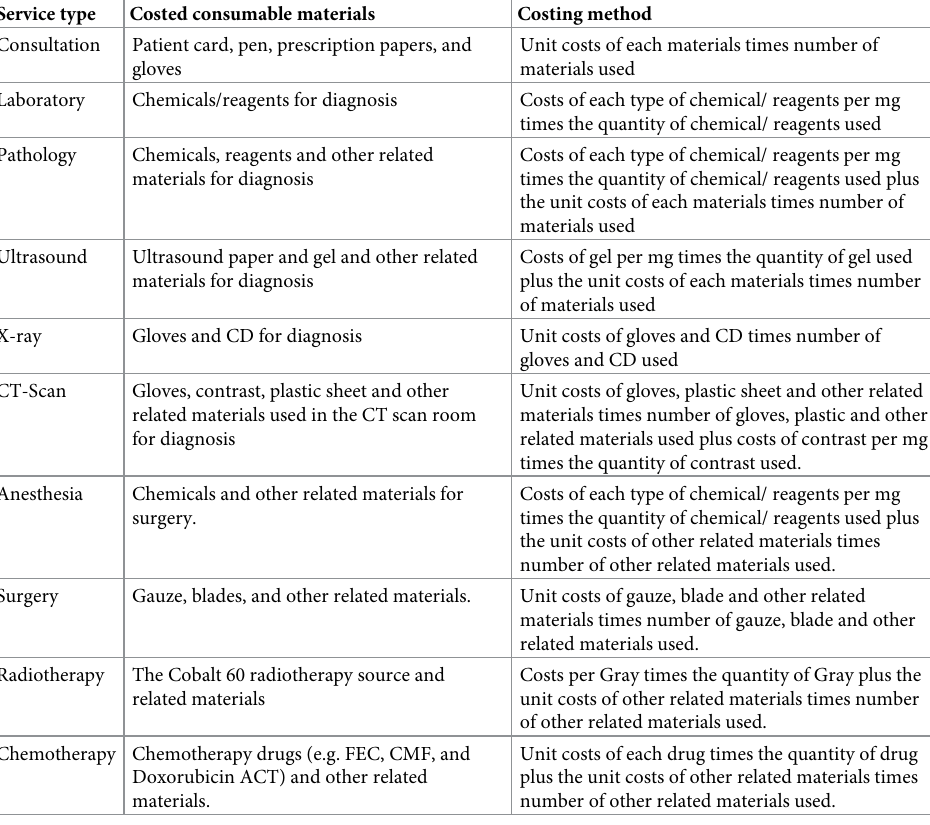
Table 2. Costed consumable